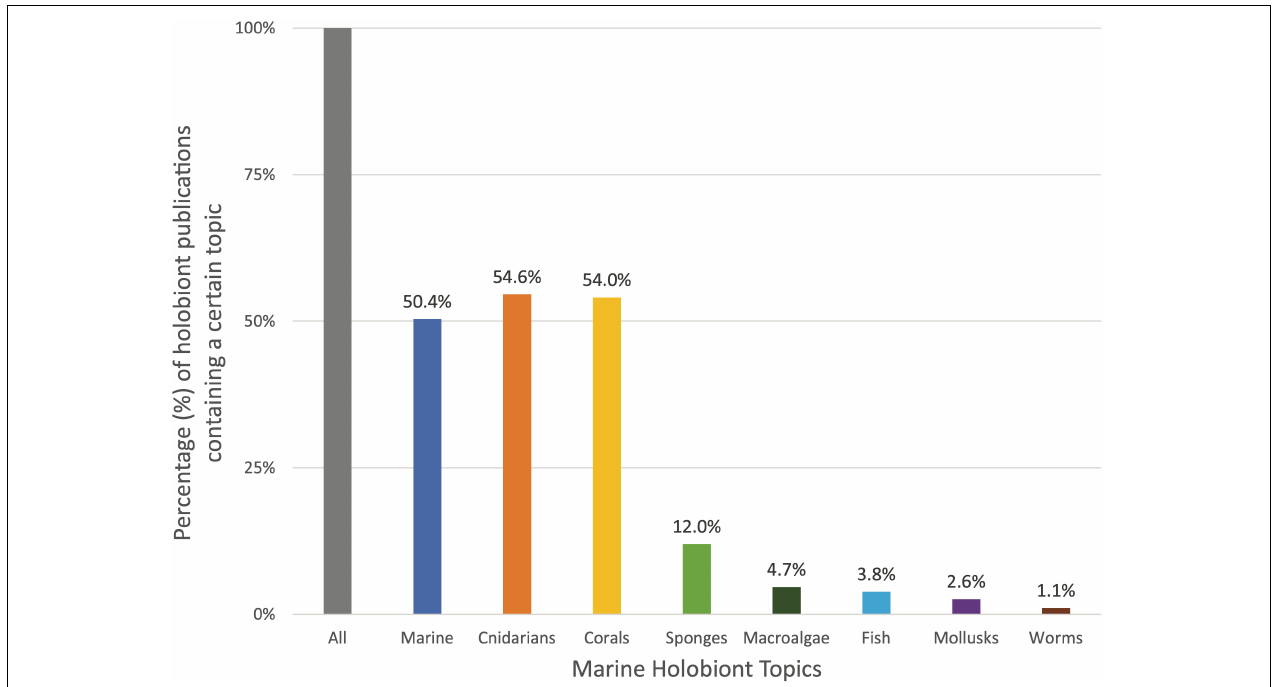
FIGURE 2 | Prevalence of certain marine topics appearing in combination with the term holobiont in the title, abstract, and/or keywords of scientific publications from 1990 to February 2021 ( N = 1269). “All” represents the entirety of publications containing the term “holobiont” (100%). The other bars indicate the percentage of publications within this list that contain terms related to a certain marine topic (cnidarians, corals, sponges, etc.). It is important to note that the different topics may overlap in several publications. For example, many publications treat of the topics of coral and sponge holobionts together. Data retrieved from the curated citation and abstract database Scopus on the date